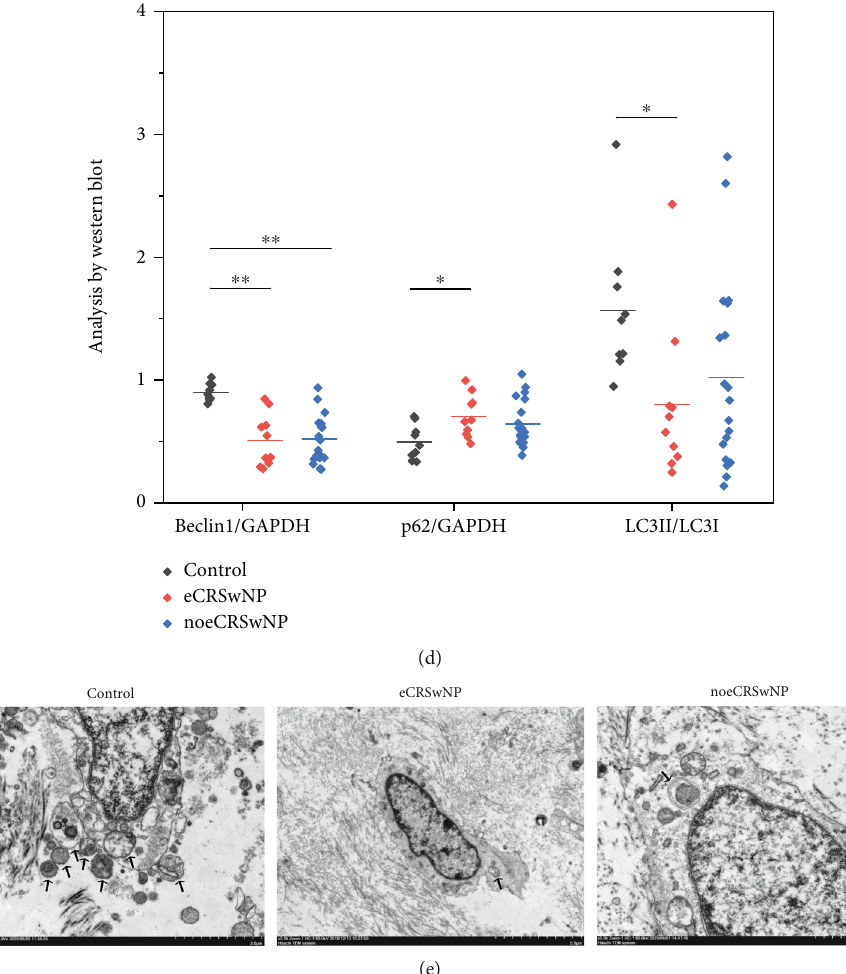
Figure 3: Autophagy levels in di ff erent CRSwNP subtypes. ( a, b) By IHC staining, the number of Beclin 1 + and LC3II + cells was signi fi cantly reduced in patients with eCRSwNP or noeCRSwNP, compared with control tissues. p62 staining revealed no signi fi cant di ff erences among the groups. (c, d) Western blot analysis showed that the levels of Beclin 1 protein in nasal polyps were downregulated in patients with eCRSwNP or noeCRSwNP, compared with control tissues. p62 protein levels increased, whereas LC3II/LC3I levels were signi fi cantly reduced, only in the nasal polyps of patients with eCRSwNP, compared with control tissues. (e) TEM showed that autophagosomes formed less frequently in the nasal polyps of patients with eCRSwNP or noeCRSwNP, compared with control tissues. Black arrow: autophagosome. ∗ P < 0 : 05 , ∗∗ P < 0 : 001